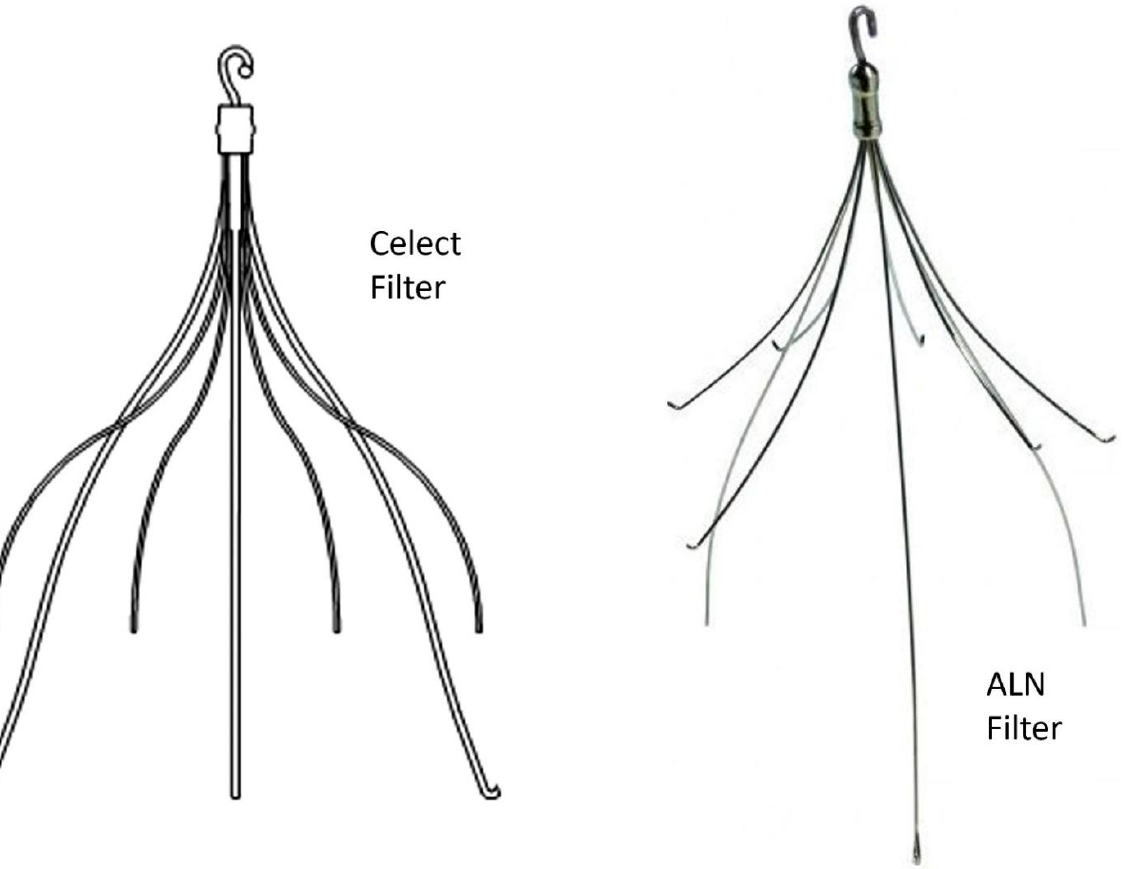
Figure 2. Types of filters compared in the trial.